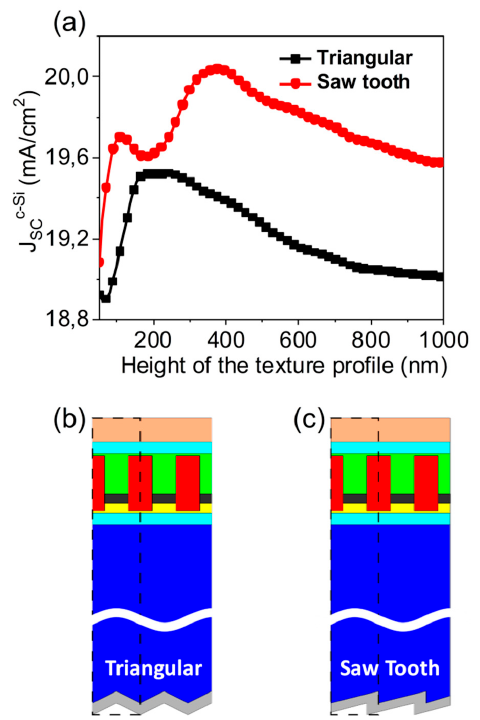
Figure 5. ( a ) Short-circuit current density generated in the c-Si subcell of the proposed device considering a textured back contact with a triangular (black squares) or a saw tooth (red circles) profile, as a function of the height of the profile. Schemes of the device with the considered profiles for the back contact are included in ( b ) and ( c ), respectively.